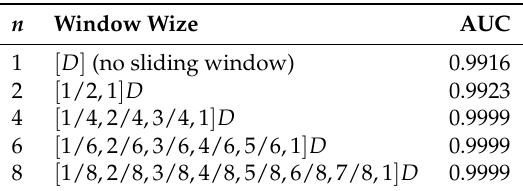
Table 3. AUC of E-CEM with a different number of sliding windows n on San Diego Data. D is the number of